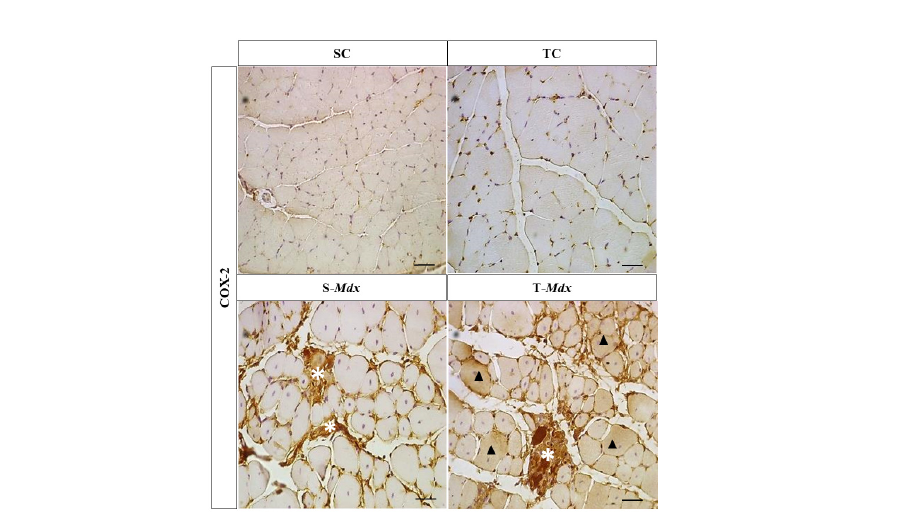
Figure - 5 Effects of exercise on COX-2 immunoexpression. Asterisks in S-Mdx and T-Mdx shows connective tissue thickening in infiltrate inflammatiory areas. In T-Mdx head arrows shows cytoplasmatic immunolabeling. Bar=50μm.